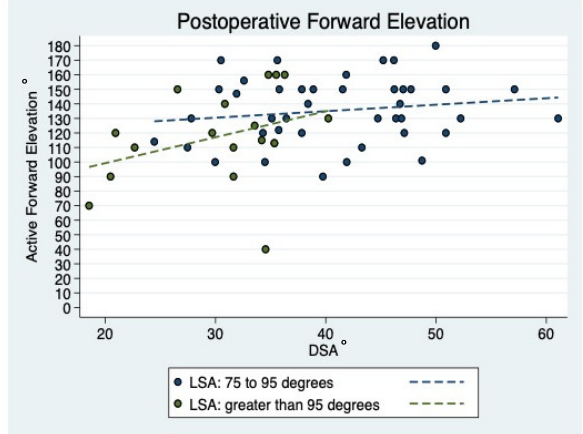
Figure 8. Scatterplot showing the linear correlation between LSA and DSA for final AFE. Good final AFE could be seen for DSA between 40 and 60 ◦ and LSA between 80 and 100 ◦ . Abbreviations: DSA = distalization shoulder angle; LSA = lateralization shoulder angle; AFE = active forward